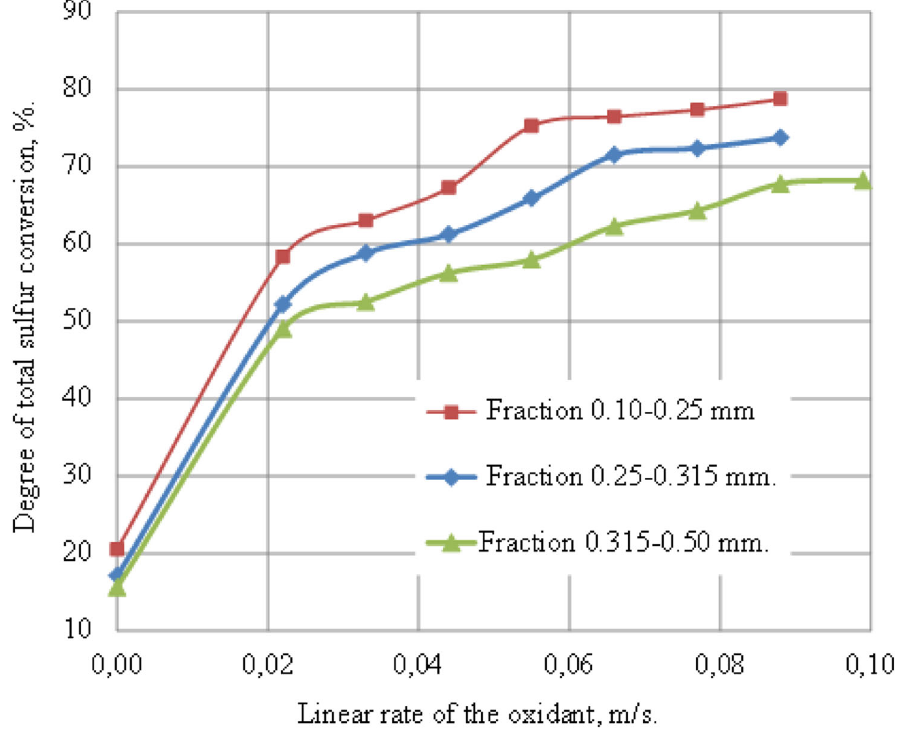
Fig. 7 The degree of total sulphur conversion versus OLV and coal particles’